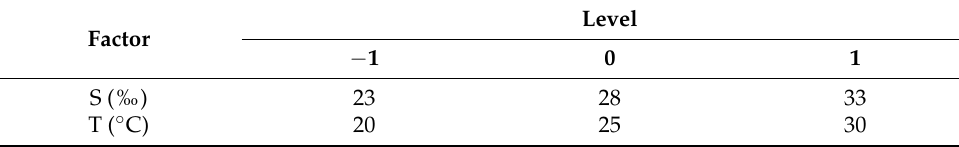
Table 1. Factors and levels table of the Box–Benhnken